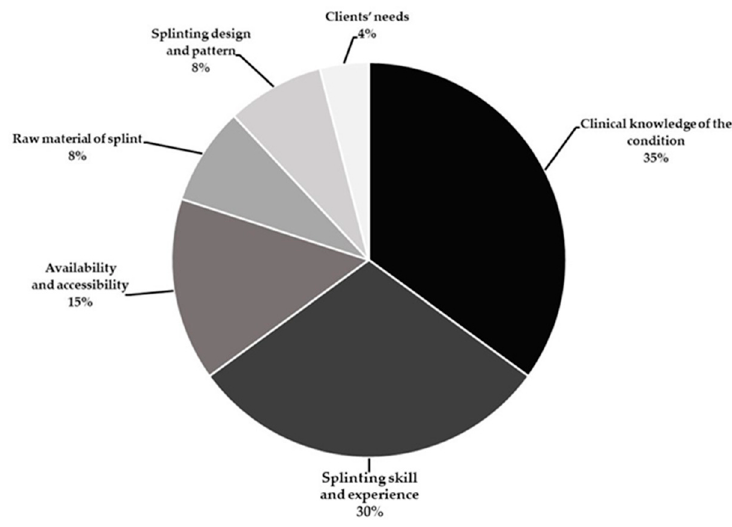
Figure 2. Therapists’ rationale for splinting selection and application ( n = 30).